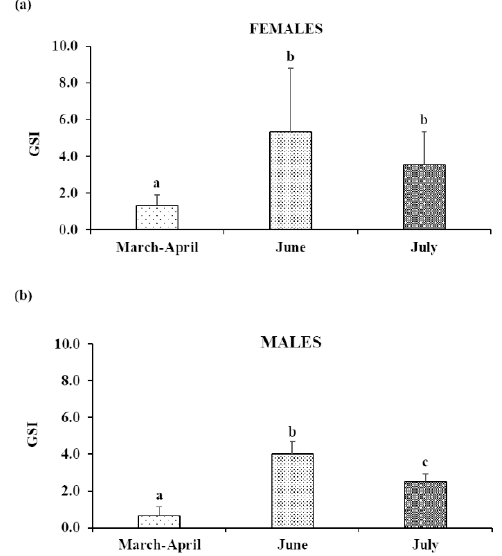
Figure 1. Mean ( ± SD) gonadosomatic index (GSI) of female ( a ) and male ( b ) meagre reared in floating sea cages in the Gulf of Taranto (North Ionian Sea, Gallipoli, Italy). Different letters indicate statistically significant differences between consecutive periods (ANOVA; p < 0.05).